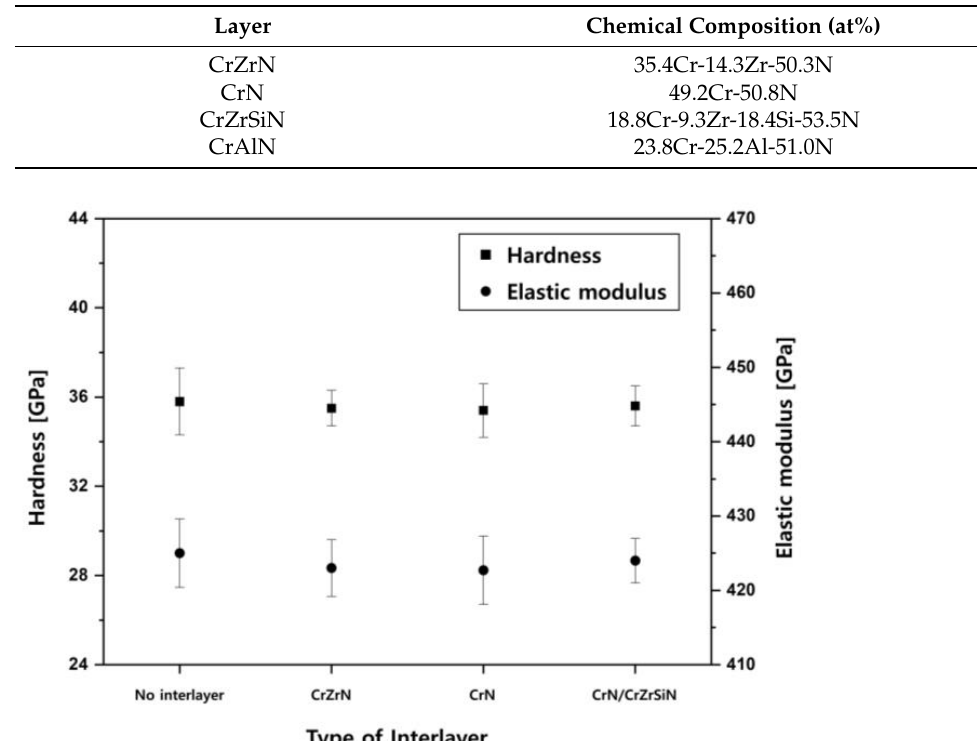
Table 1. Chemical composition of CrZrN, CrN, and CrZrSiN interlayers and the CrAlN coating.